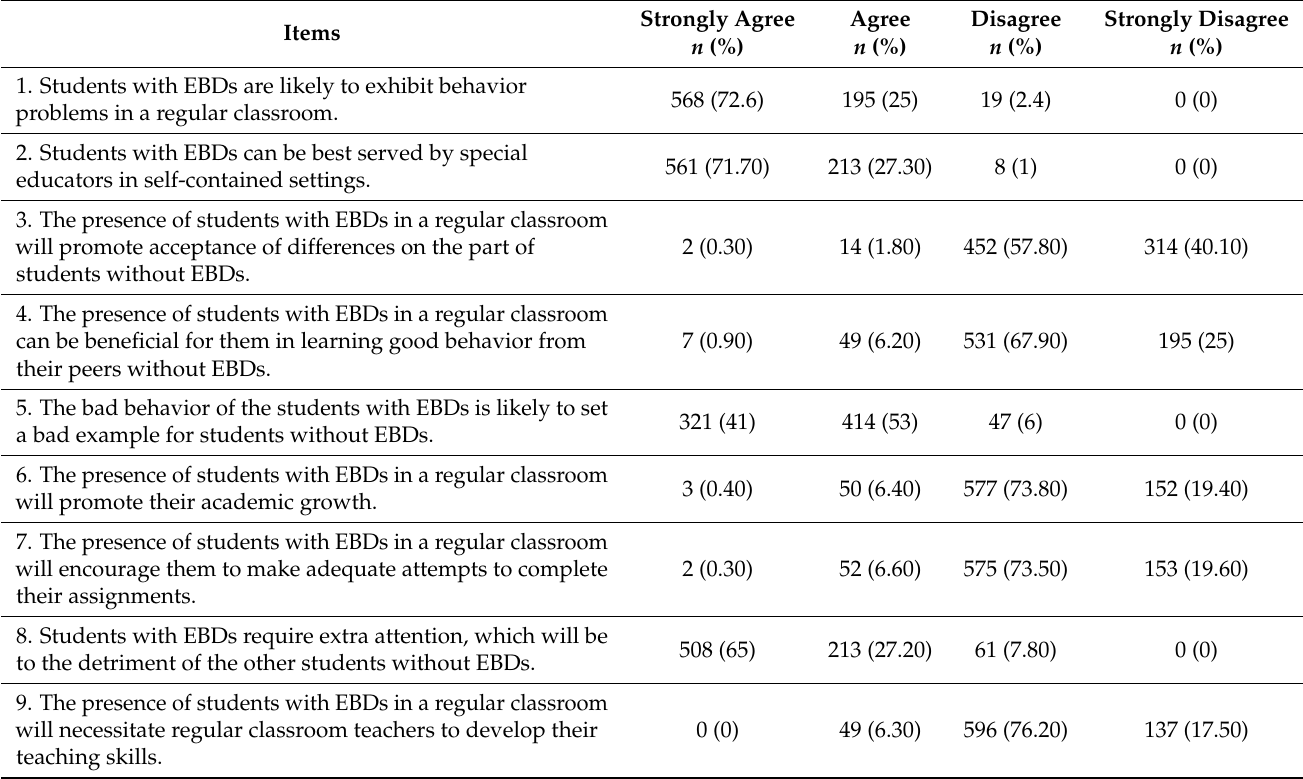
Table 2. Participants’ responses on the GEAEBDQ ( n =